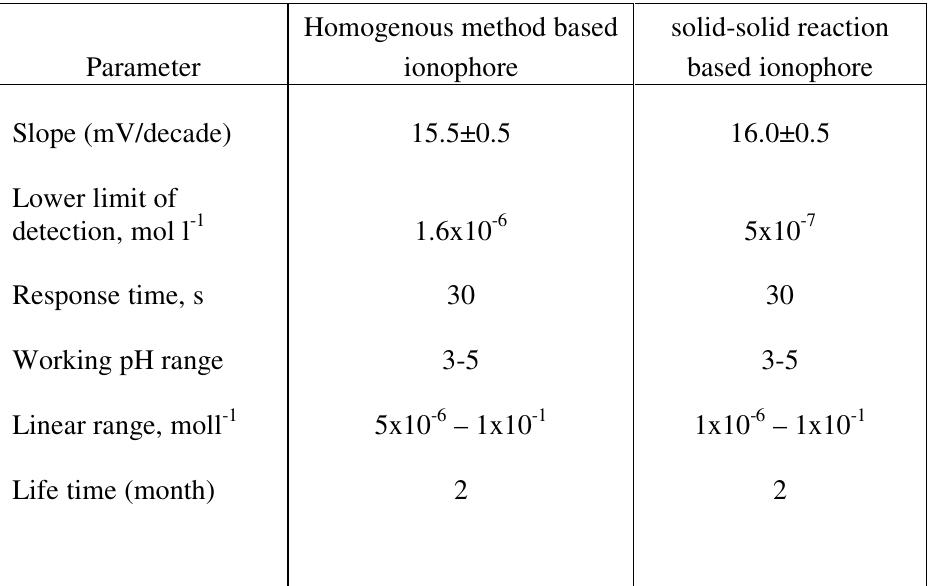
Table 1 Potentiometric response characteristics of the coated graphite rod based thorium